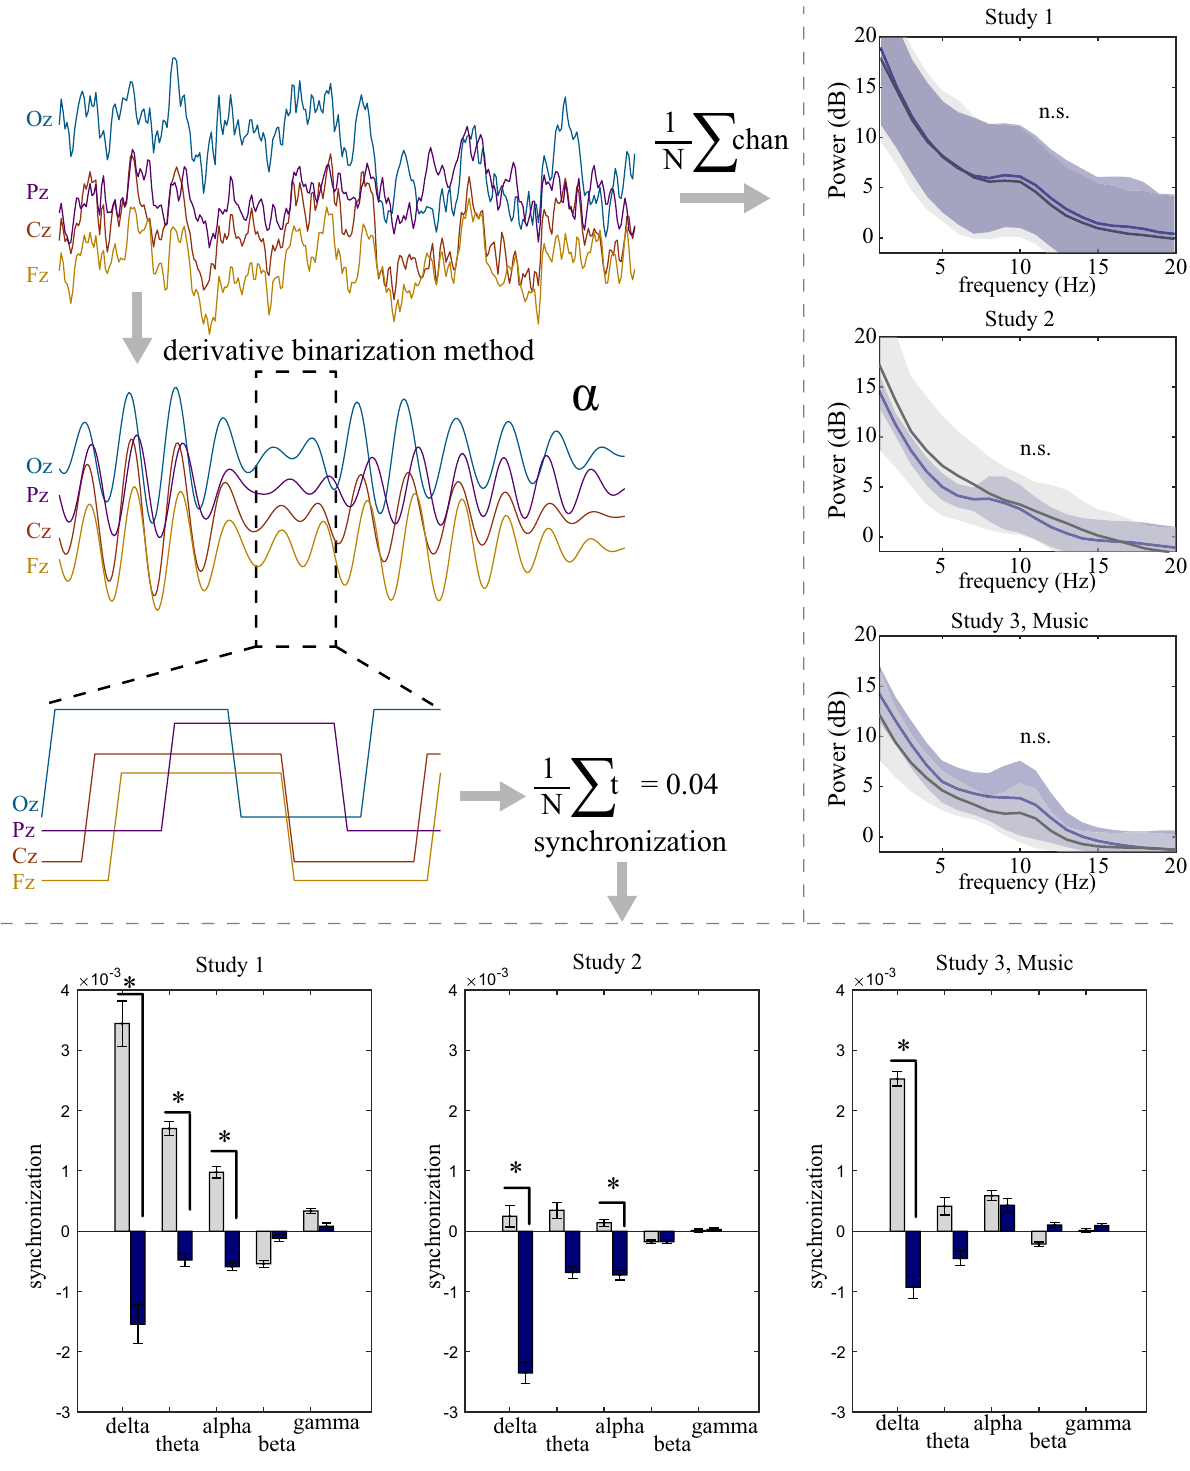
Figure 4. Power and synchronization during the manually controlled and self-driving conditions. Sample participant fluctuations for approximately 1.5 s of EEG data for the midline electrodes and trajectories to the two different analyses: (i) Right, the average power across frequencies for both the manually controlled and self-driving conditions; and (ii) Bottom, the bandpass filtered and binarized segments of the binarized derivative method (BDM), as shown for a small segment of the EEG, where the binarized signals are then summed and averaged to estimate the synchronization of the signals. Right panel: Mean power spectral density across frequencies for both driving conditions for Studies 1–3. Blue = self-driving, gray = manually controlled. Semi-transparent shading surrounding this average indicates the standard deviation across participants. Lower panel: Mean synchronization for 5 frequency bands (delta: 1–3 Hz,